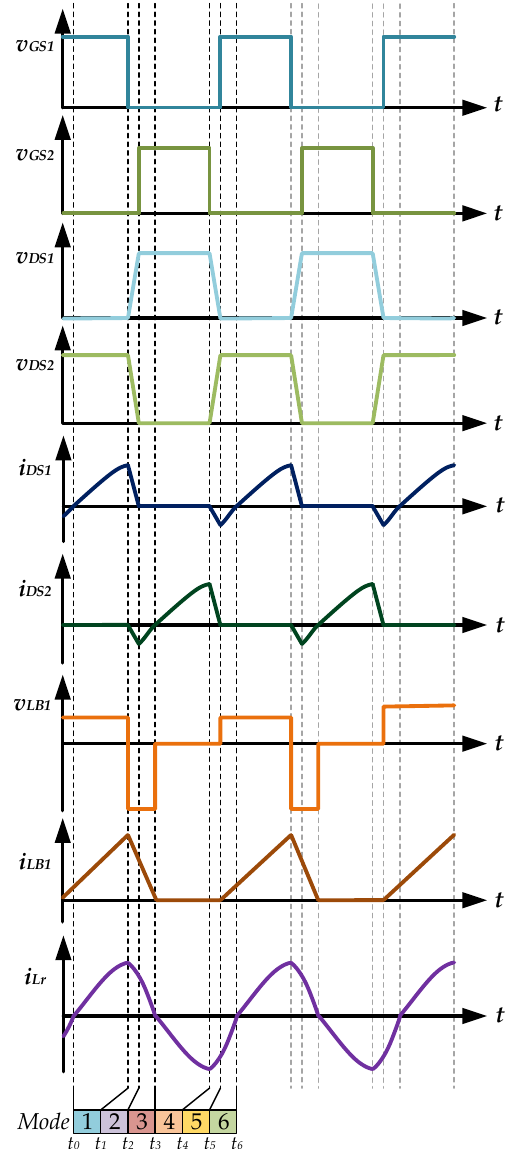
Figure 12. Theoretical waveforms of the proposed drive circuit of the piezoelectric ceramic actuator during the positive half-cycle of the utility-line voltage.